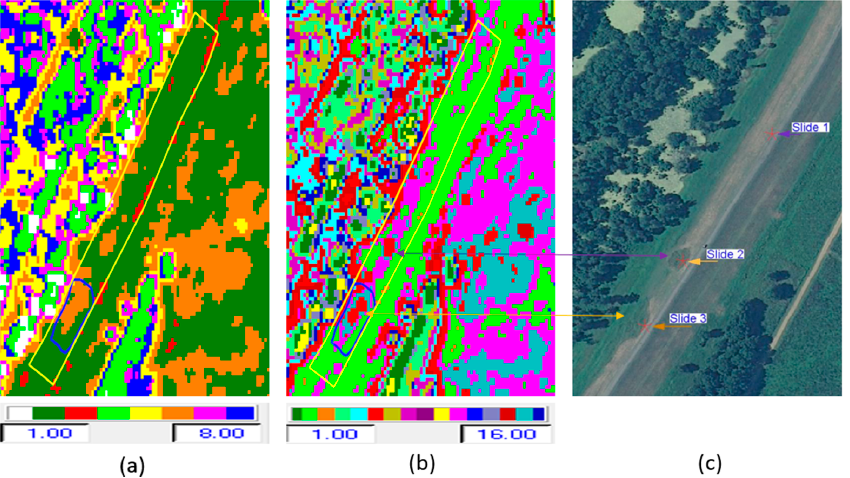
Figure 7. ( a – c ) Wishart-H/ α classification, Wishart-H/A/ α classification, and optical image. Figure 8a–f shows: (a) The Pauli RGB image, (b) H/ α classification (repeated for comparison), (c) H/ α / λ classification, (d) H/ α / λ 1 classification, (e) H/ α / λ 2 classification, and (f) H/ α / λ 3 classification.